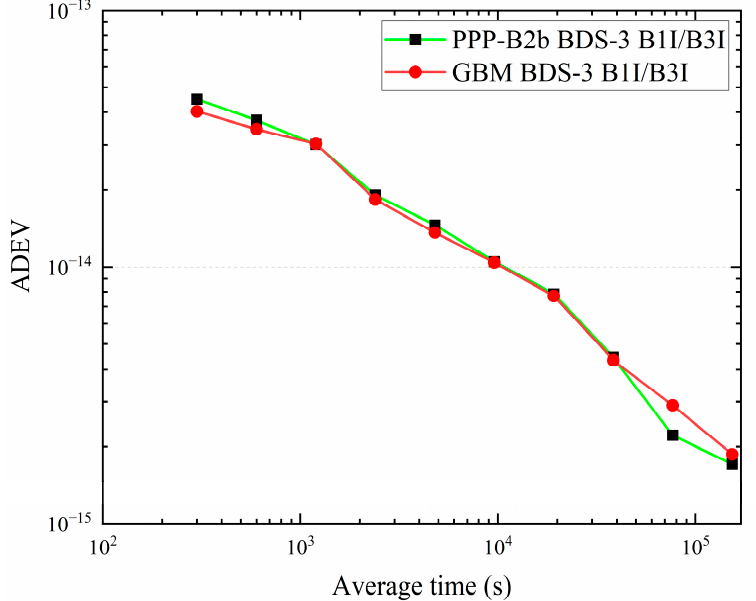
Figure 15. The Allan of NTSC-TL time comparison using the PPP-B2b product and the GBM product via PPP.